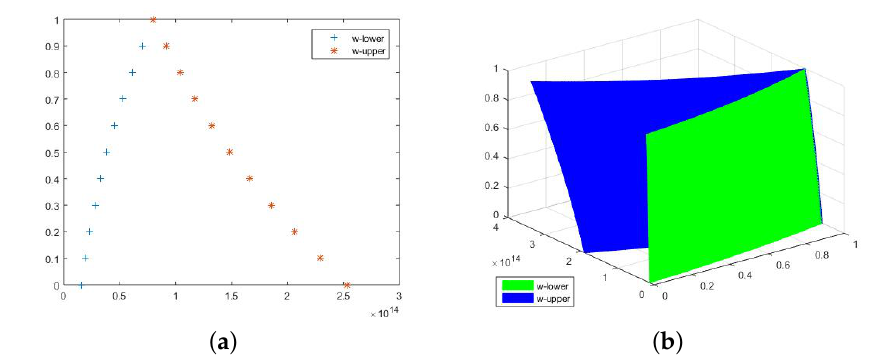
Figure 7. The exact lower and upper solutions of Equation (156) at Λ = 0.9, ϕ = 0.5, φ = 0.4, t = 7, (cid:61) = 1, ı = 4. ( a ) 2 D figure for the exact solutions of three-dimensional fuzzy fractional diffusion equation of w in Example 10. ( b ) 3 D figure for the exact solutions of w in Example